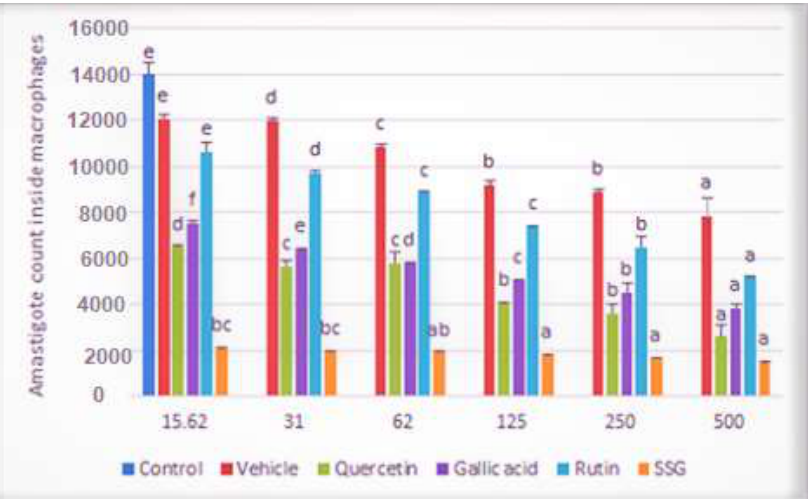
Figure 2. Graph showing amastigote count inside 1000 raw macrophages following treatment with quercetin, gallic acid, and rutin at 15.62 µg/mL–500 µg/mL after 72 h of incubation compared with vehicle control. Data represent the mean values of three replicates with ± standard error. Different labels on column data show significant difference at ( p < 0.05). Micrographs of Giemsa-stained L.-donovani -infected macrophages incubated with quercetin, gallic acid, and rutin are shown in Figure 3.